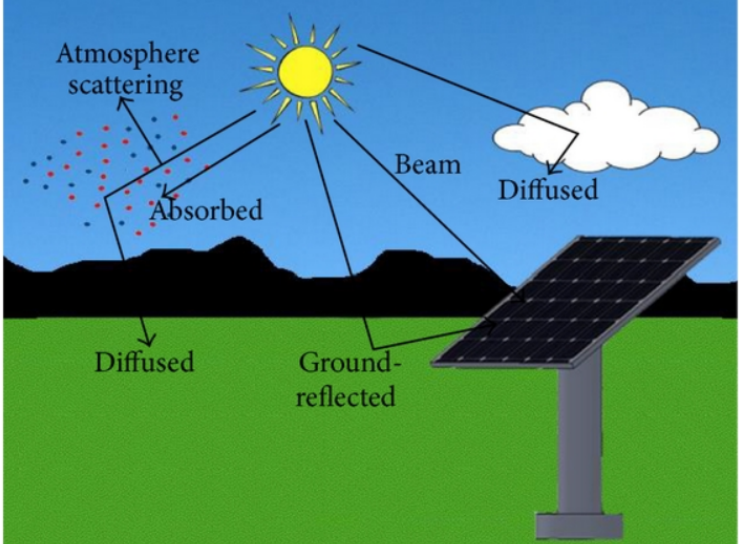
Figure 9. Incoming solar irradiance interaction with atmospheric components